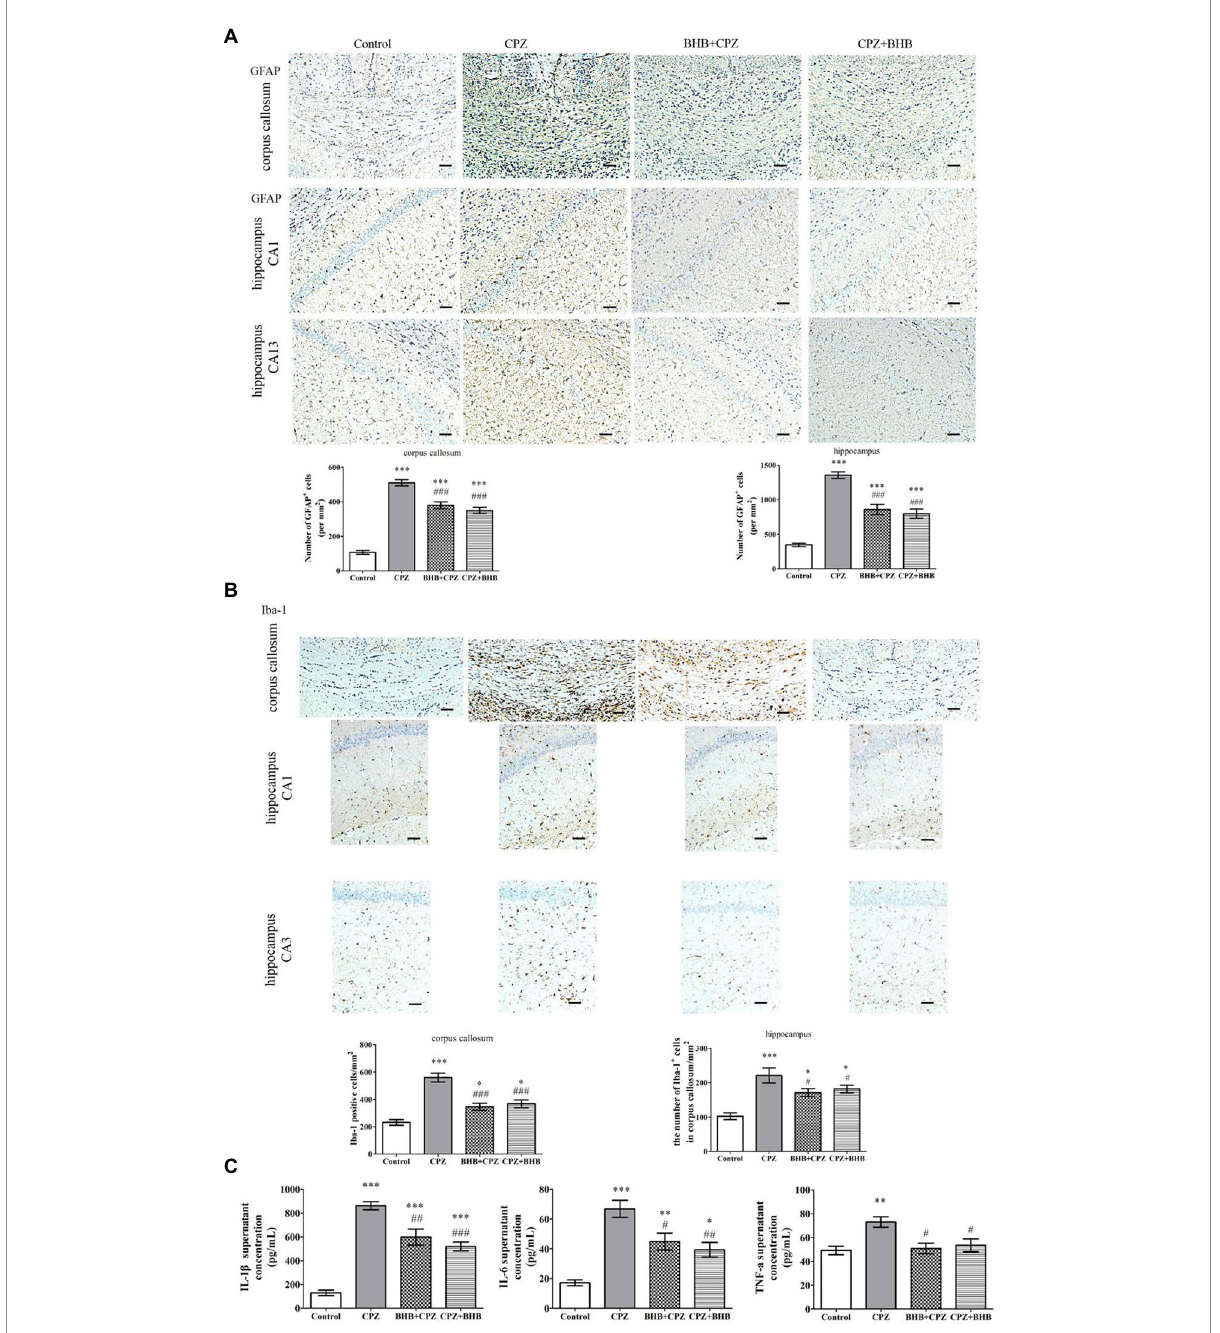
FIGURE 6 Immunohistochemistry for the microglia and astrocytes in the corpus callosum and hippocampus, and the levels of IL-1 β , IL-6, and TNF- α in brains of mice at day 35 after CPZ induction. (A) Representative GFAP staining and intensity quantification in the corpus callosum and hippocampus of CPZ-fed mice in different groups. (B) Representative Iba-1 staining and intensity quantification in the corpus callosum and hippocampus of CPZ- fed mice in different groups. (C) IL-1 β , IL-6 and TNF- α levels in brains were analyzed by ELISA. Data are presented as mean ± SEM. N = 3 per experimental group; experiment repeated two times. Scale bars = 50 μ m. * p < 0.05, ** p < 0.01, and *** p < 0.001 versus the control group; # p < 0.05, ## p < 0.01, and ### p < 0.001 versus the CPZ